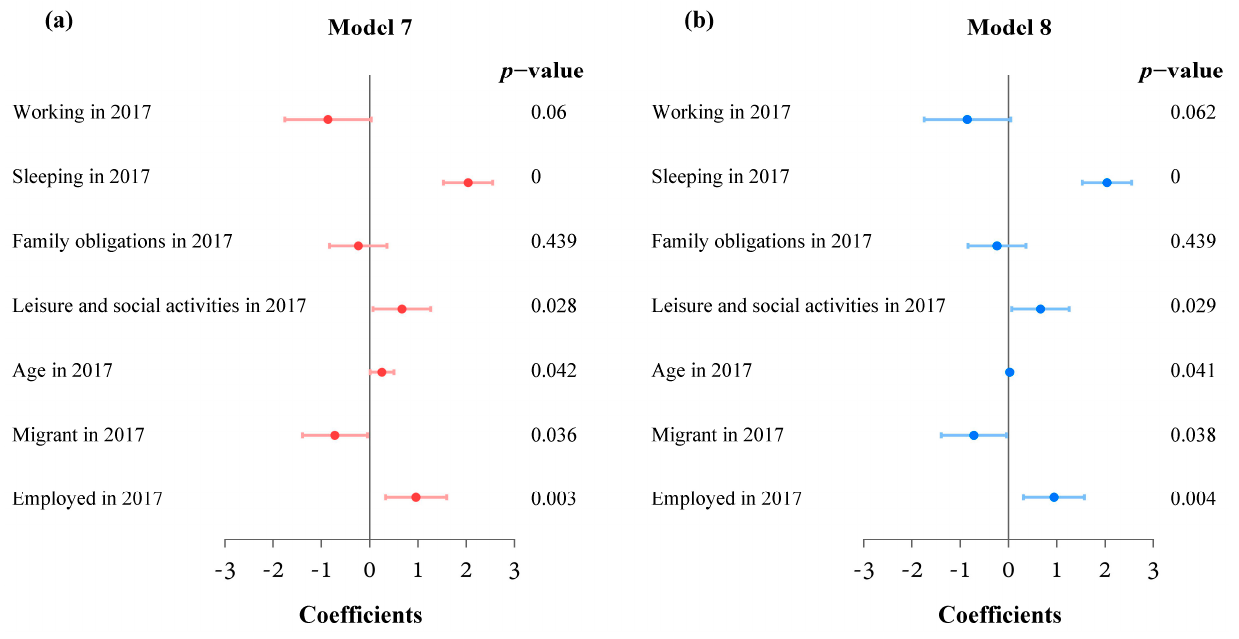
Figure 6. ( a ) Forest plot of some estimated coefficients in model 7 and ( b ) model 8.